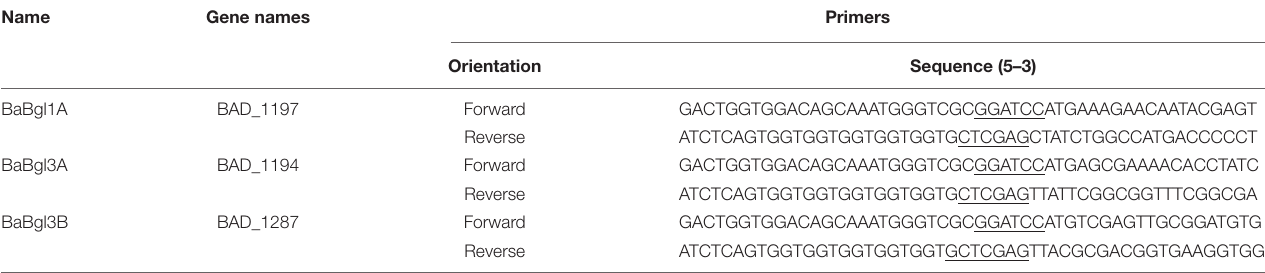
TABLE 1 | Summary of cloned glucosidase genes from Bifidobacterium adolescentis